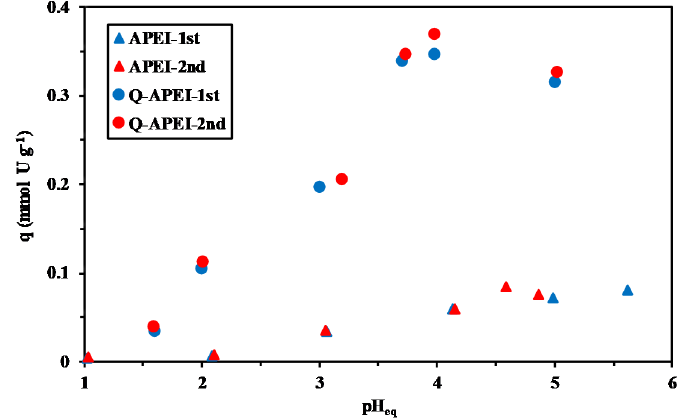
Figure 3. Effect of pH on U(VI) sorption using APEI and Q-APEI sorbents (Sorbent dosage (SD): 0.333 g L −1 ; contact time: 48 h; agitation speed: 170 rpm; T: 22 ± 2 °C).